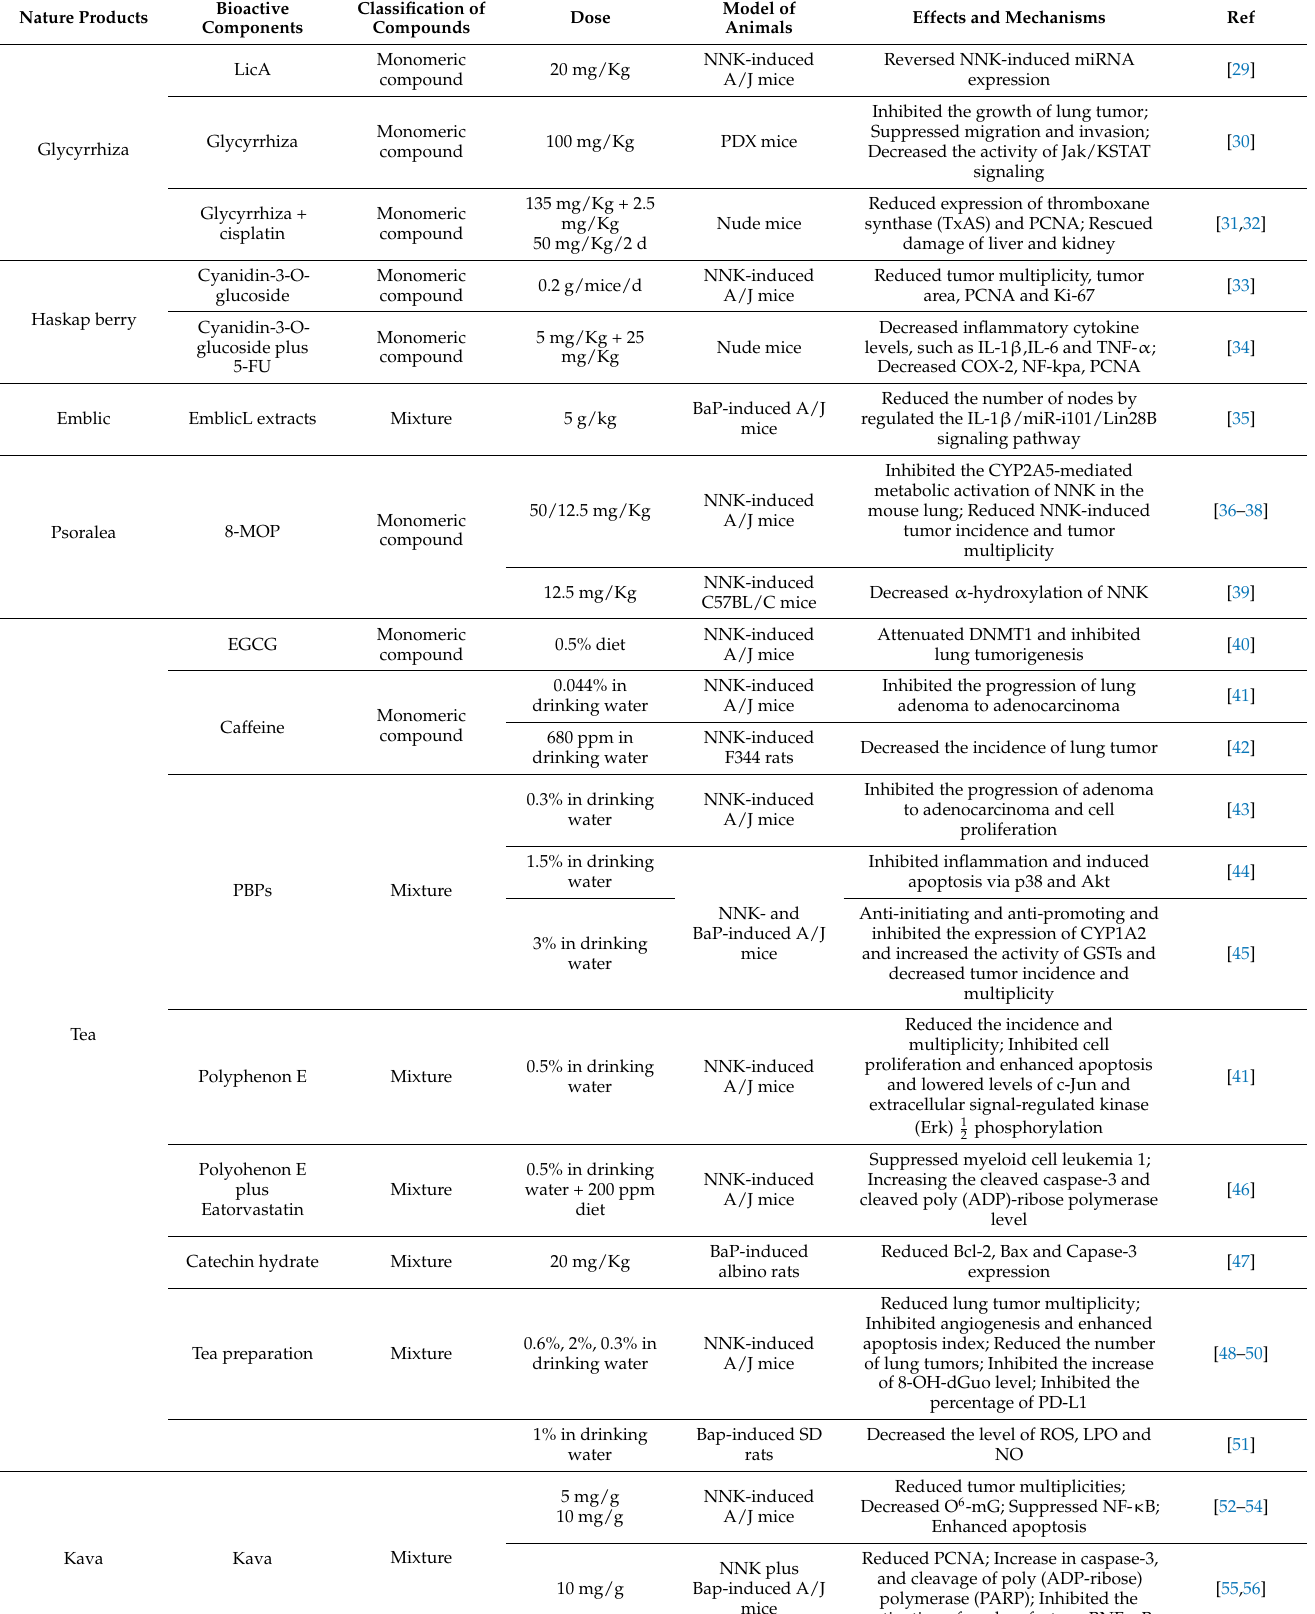
Table 1. Summary of the in vivo studies describing dietary phytochemicals for lung cancer